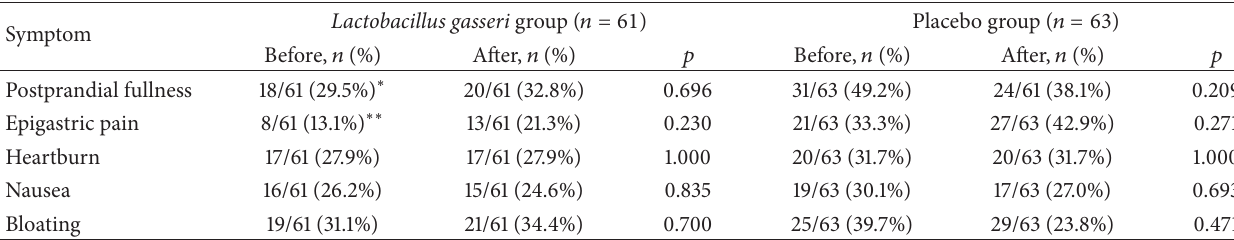
Table 3: Dyspeptic symptoms.